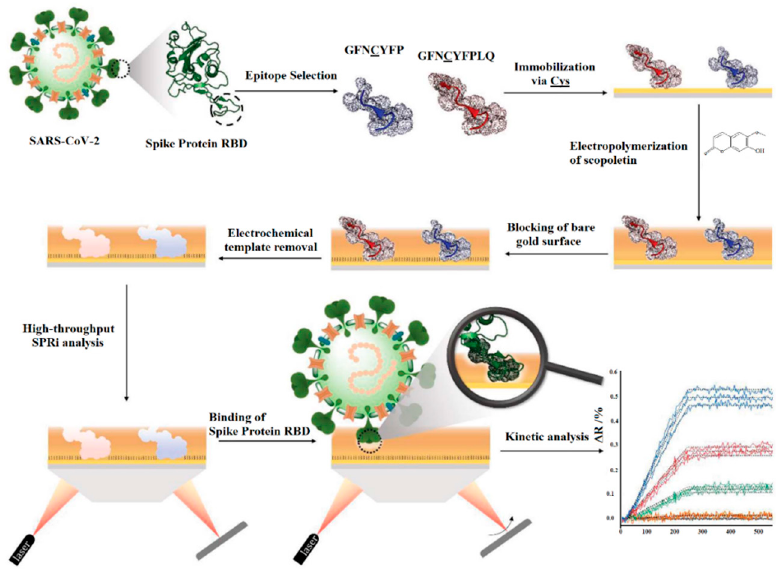
Figure 6. Schematic representation of steps of virus imprinting procedure preparation and the SPR responses of the rebinding Reprinted with permission from [82]. 2022, RSC. responses of the rebinding Reprinted with permission from [82]. 2022,